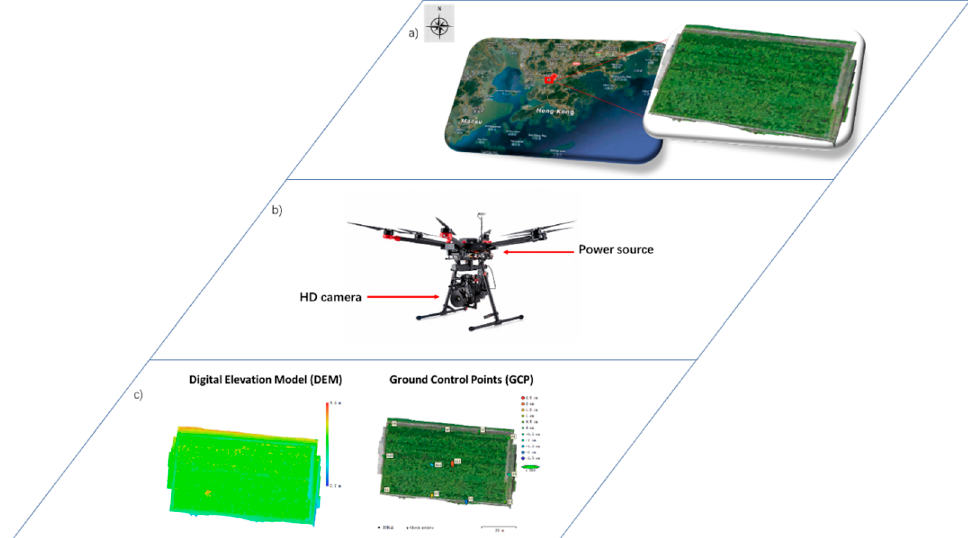
Figure 1. ( a ) Location of experimental plot, ( b ) unmanned aerial vehicle platform, and ( c ) ground control points, and ground control points in acquired data.